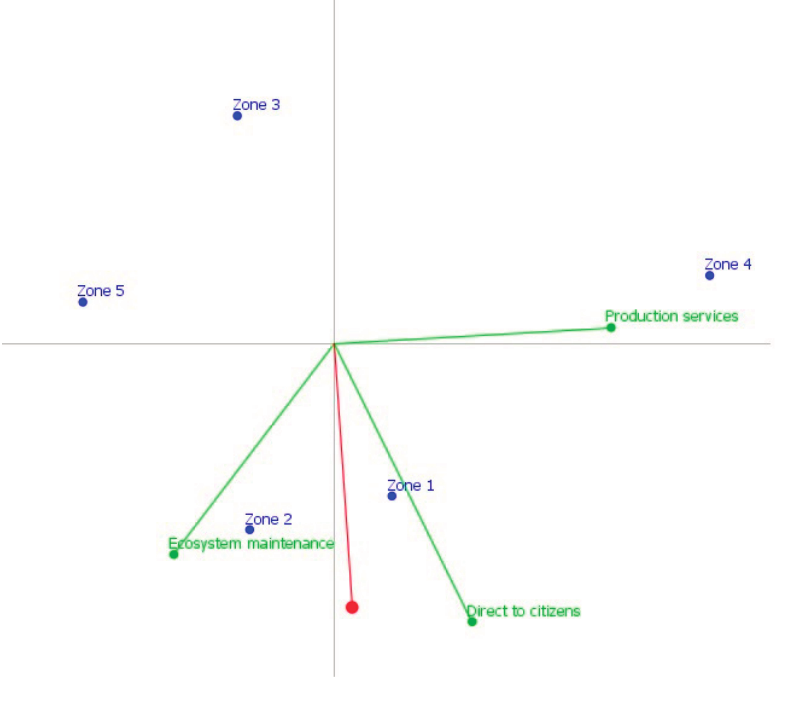
Figure 7. Global Visual Analysis for the Serra d’Espadà Natural Park. D-Sight